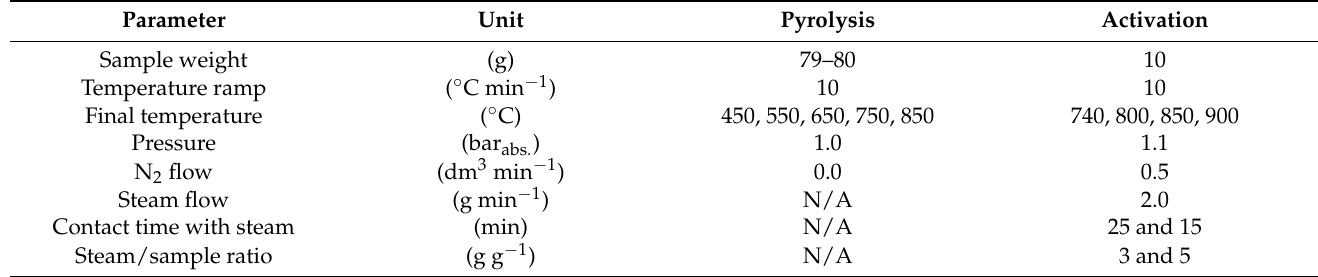
Table 2. The main parameters of the pyrolysis and activation parts of the